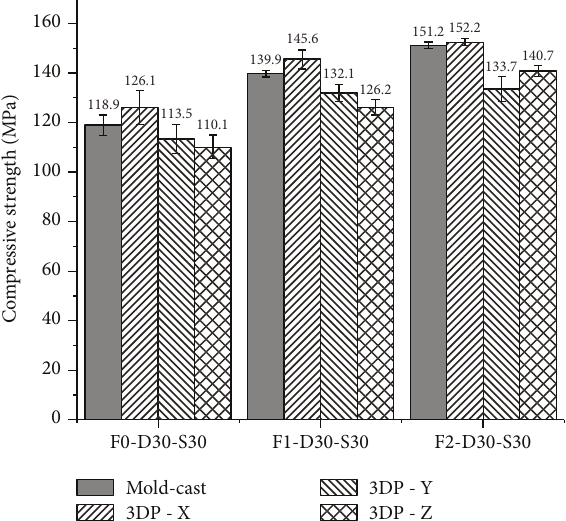
Figure 12: Compressive strength maps of printed sample and conventional cast sample with different fiber doping ratios [32].